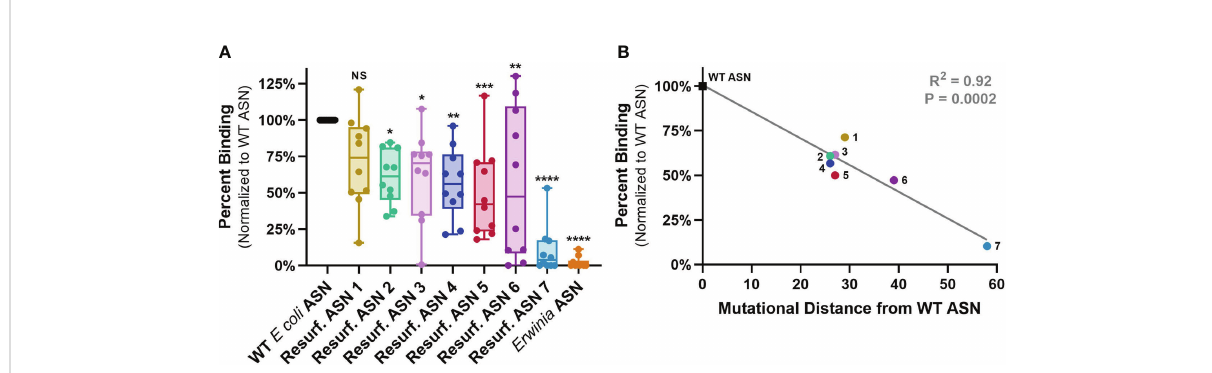
FIGURE 4 ASN Re-surfacing disrupts binding to human ADAs. Anti-ASN ADA titers were quanti fi ed against WT ASN for each sample via ELISA with the dilution exhibiting 80% of max binding signal utilized to measure relative binding to Resurf. ASN variants (See Supplementary Figure 1). (A) Human serum or plasma sample binding to Resurf. ASNs normalized to binding against WT ASN as assayed by IgG ELISA. Each dot is the mean of an individual patient sample tested in technical triplicate. All ASN variants except Resurf. ASN 1 exhibited signi fi cant reductions in normalized binding via one-way analysis of variance (ANOVA), * P < 0.05, ** P < 0.01, *** P < 0.001, **** P < 0.0001. (B) The mean normalized percent binding across all patient samples to each ASN is plotted against the mutational distance of the molecule to WT ASN and shows a signi fi cant negative correlation via linear regression analysis, R 2 = 0.92, P = 0.0002. Data are representative of N = 3 independent experiments. Please see Supplementary Figure 2 for binding assessment normalized to relative abundance of plate bound protein measured by anti-His ELISA. NS, not signi fi cant